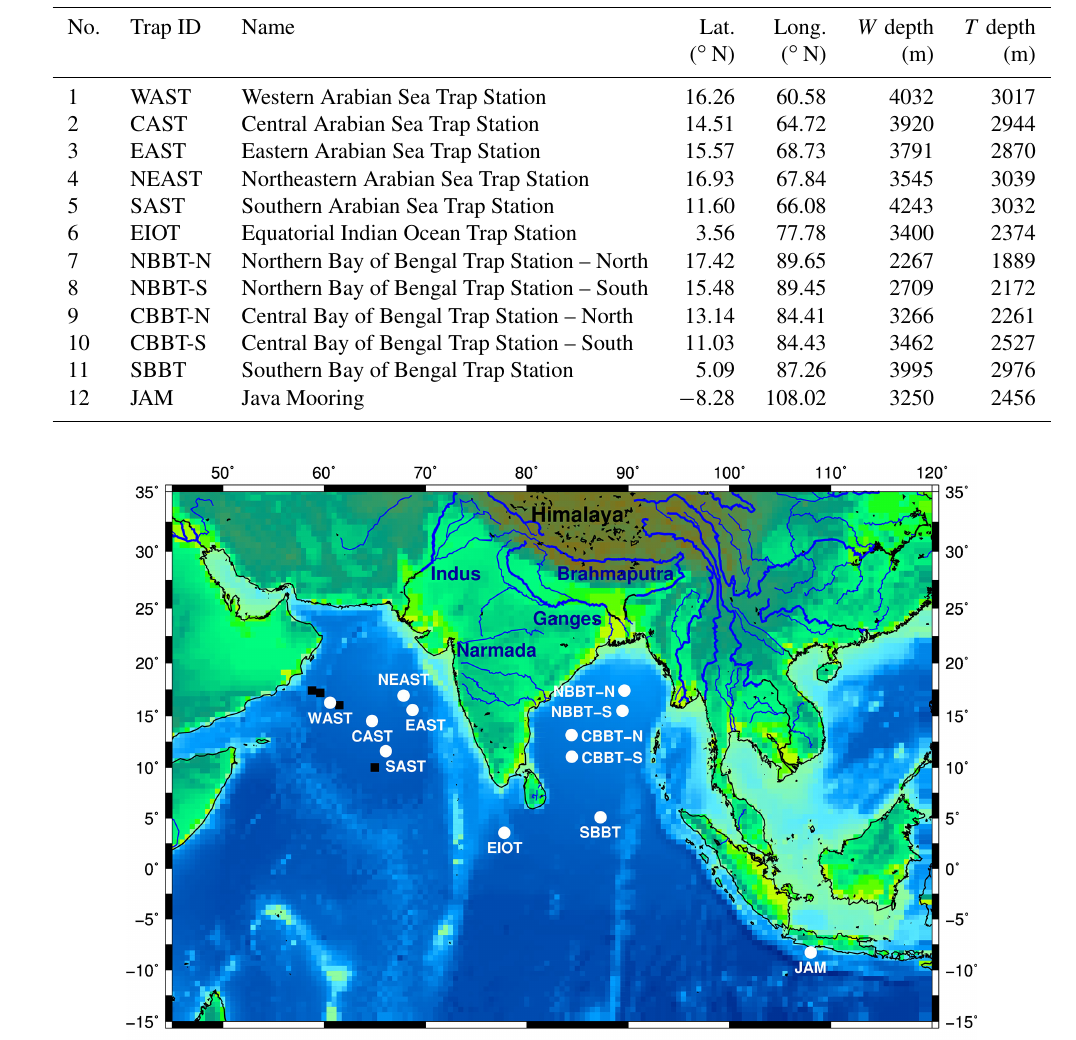
Table 1. Number of station, trap ID, station name, position, water depth and trap depth.